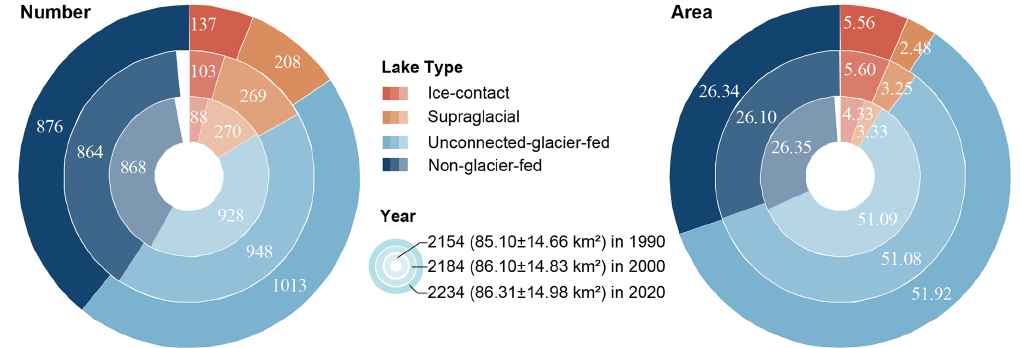
Figure 6. The number and area of different types of glacial lakes are classified based on the condition of glacier supply in the study area (GLCS1). The outermost ring represents glacial lake data for 2020, the middle ring for 2000 and the innermost ring for 1990. Lake number and area in 2020 were selected as references, meaning a concept of “100%” for a complete ring. Labeled values are scaled in degrees rather than the radius of